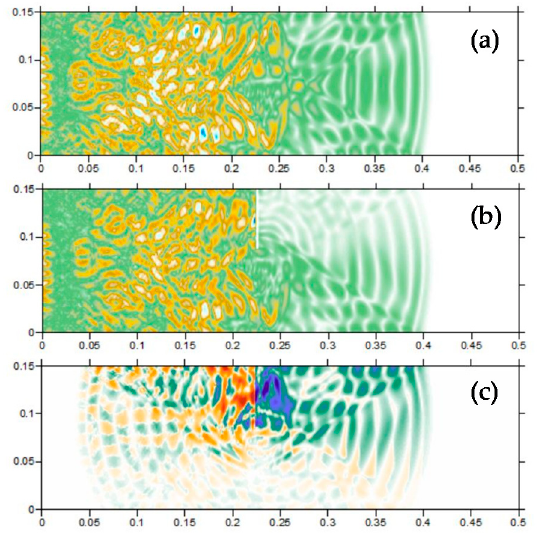
Figure 5. Wave field in homogeneous models: ( a ) healthy beam; ( b ) damaged beam; ( c ) The difference wave field of the healthy and damaged beam.